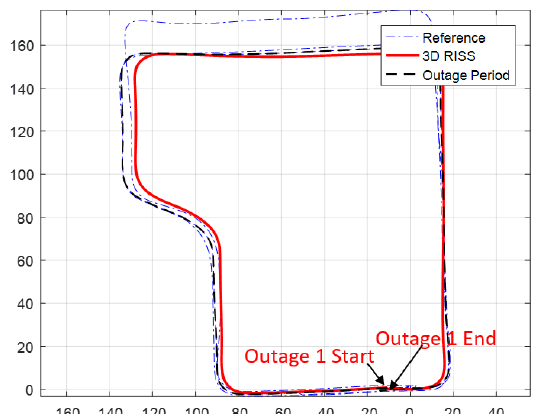
Figure 16. Typical 3D RISS trajectory for 90 seconds GNSS signal outage